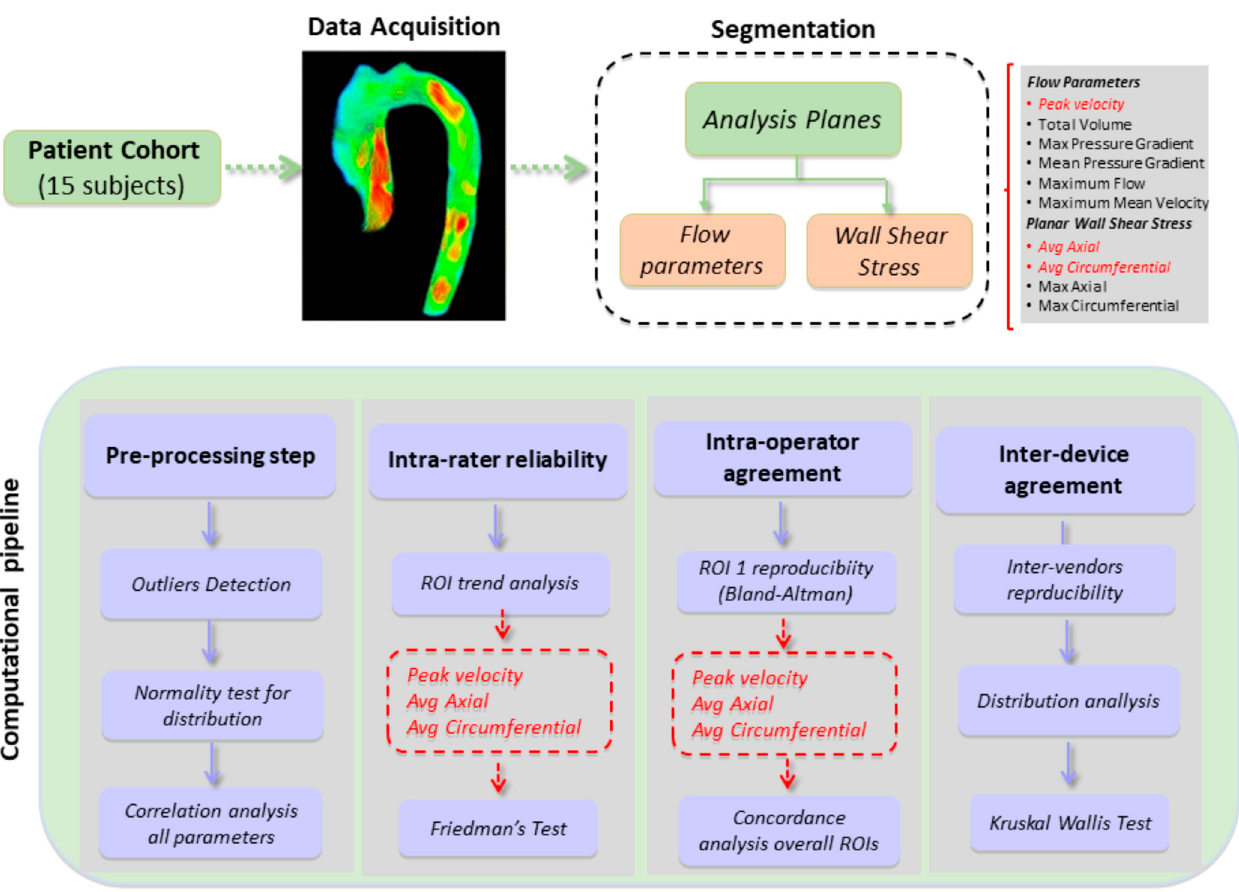
Figure 2. Figure 2. Work fl ow.